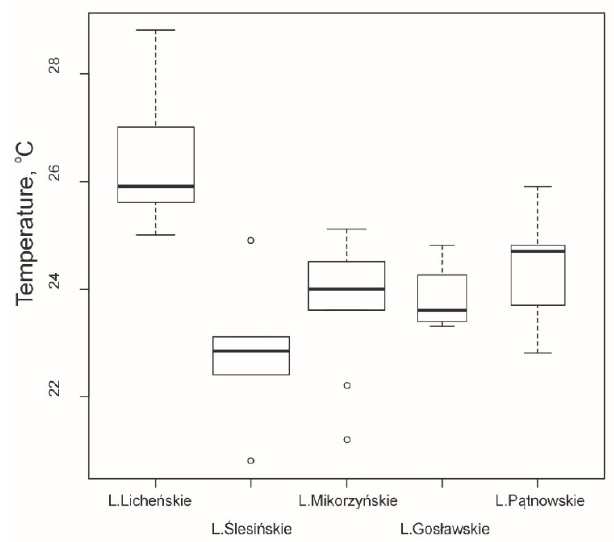
Figure 2. Comparison of water temperature in the epilimnion of the Konin lakes in the summer (1965– 2018).